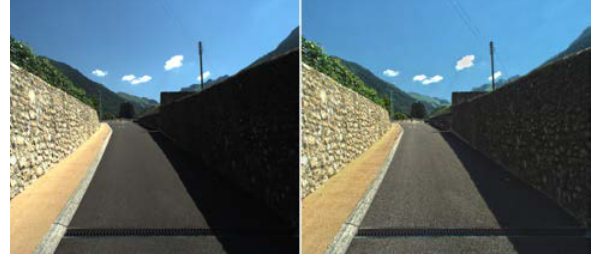
Figure 7. Tone mapping example (left = original, right = enhanced)